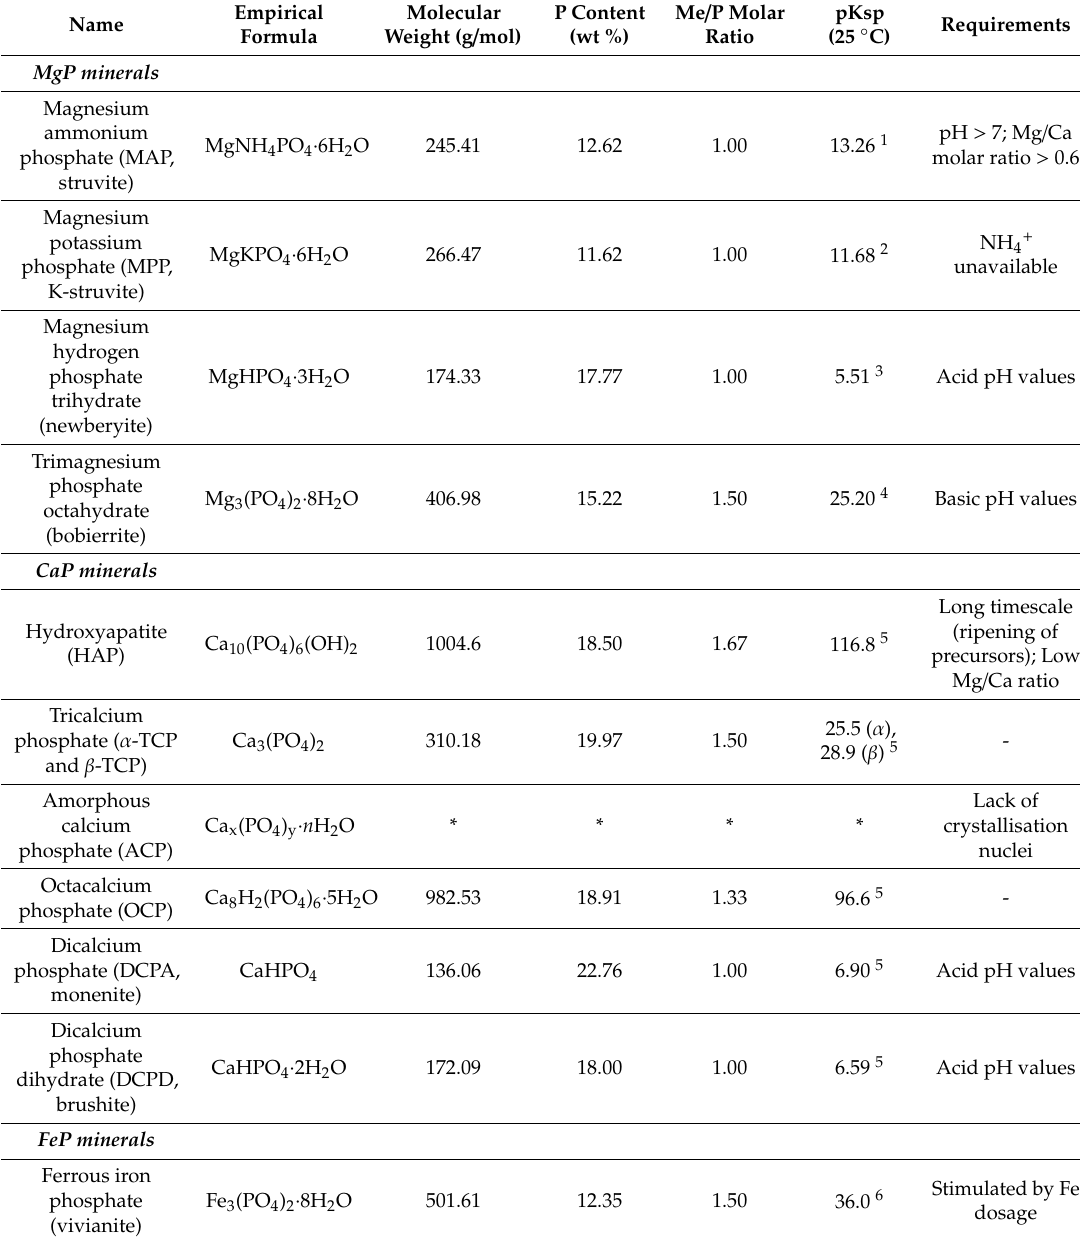
Table 1. Main phases of interest regarding magnesium phosphates (MgP), calcium phosphates (CaP), and iron phosphates (FeP) when applying mineral precipitation aimed at phosphorus recovery in waste water treatment. Me, metal—Mg, Ca or